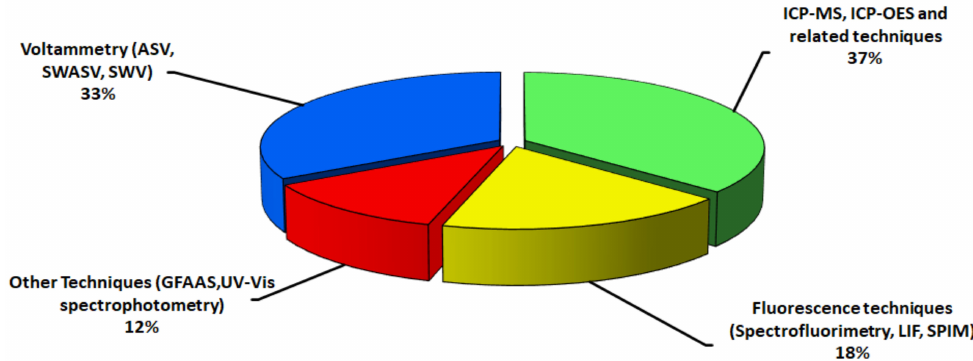
Figure 8. Sector graph of analytical techniques for detection/determination of